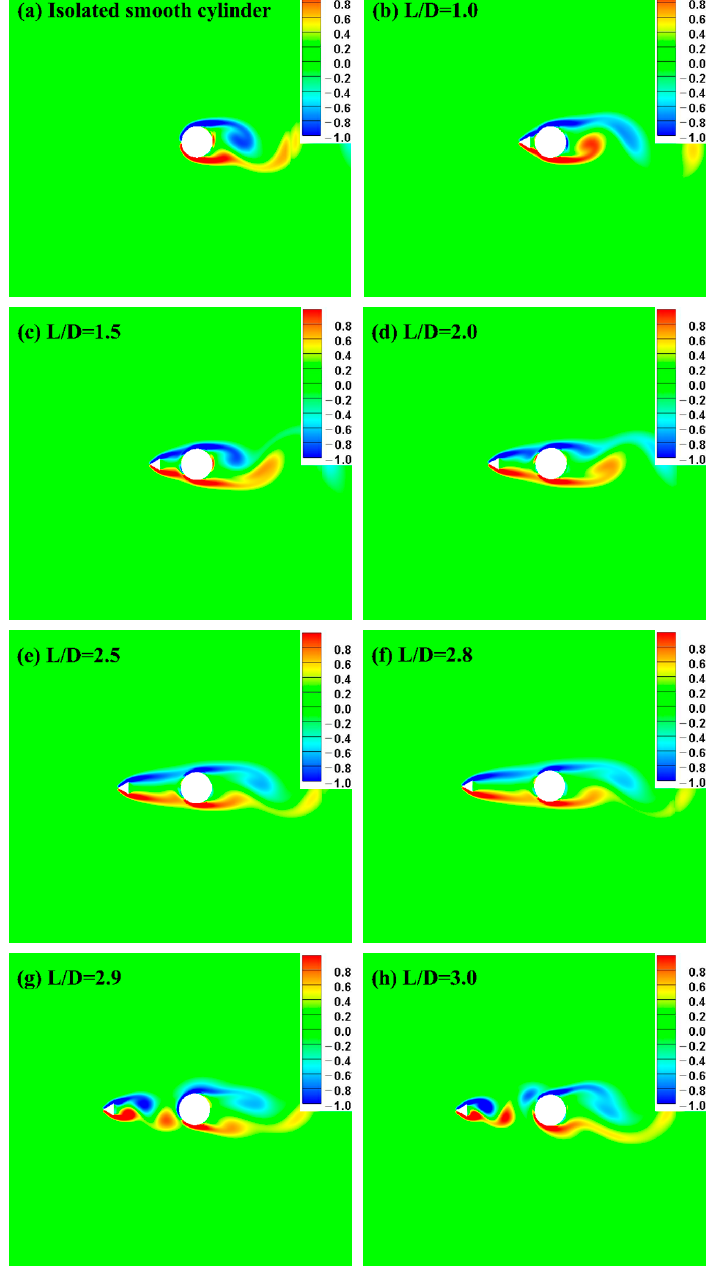
Figure 4. Contours of vorticity for different spacing ratios of L/D at Re = 200, ( a ) isolated smooth cylinder; ( b ) L/D = 1.0; ( c ) L/D = 1.5; ( d ) L/D = 2.0; ( e ) L/D = 2.5; ( f ) L/D = 2.8; ( g ) L/D = 2.9; ( h ) L/D = 3.0.